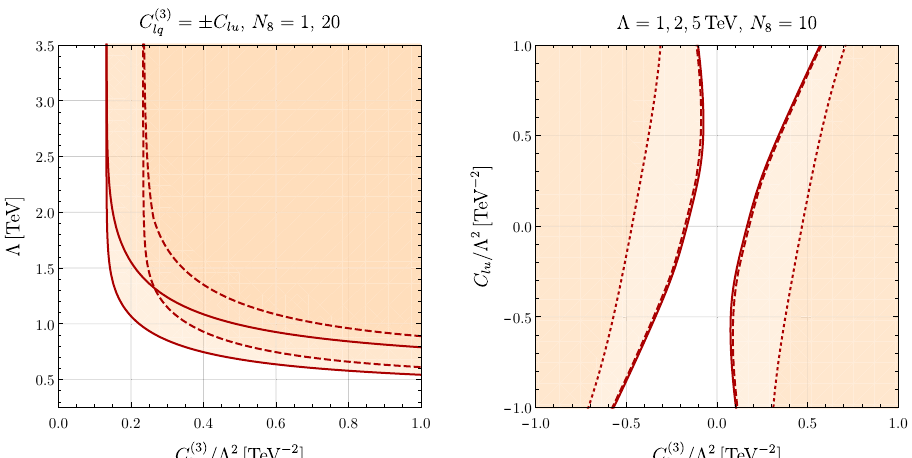
= C lu lq − affects the value of the 8 = 20. In the right 8